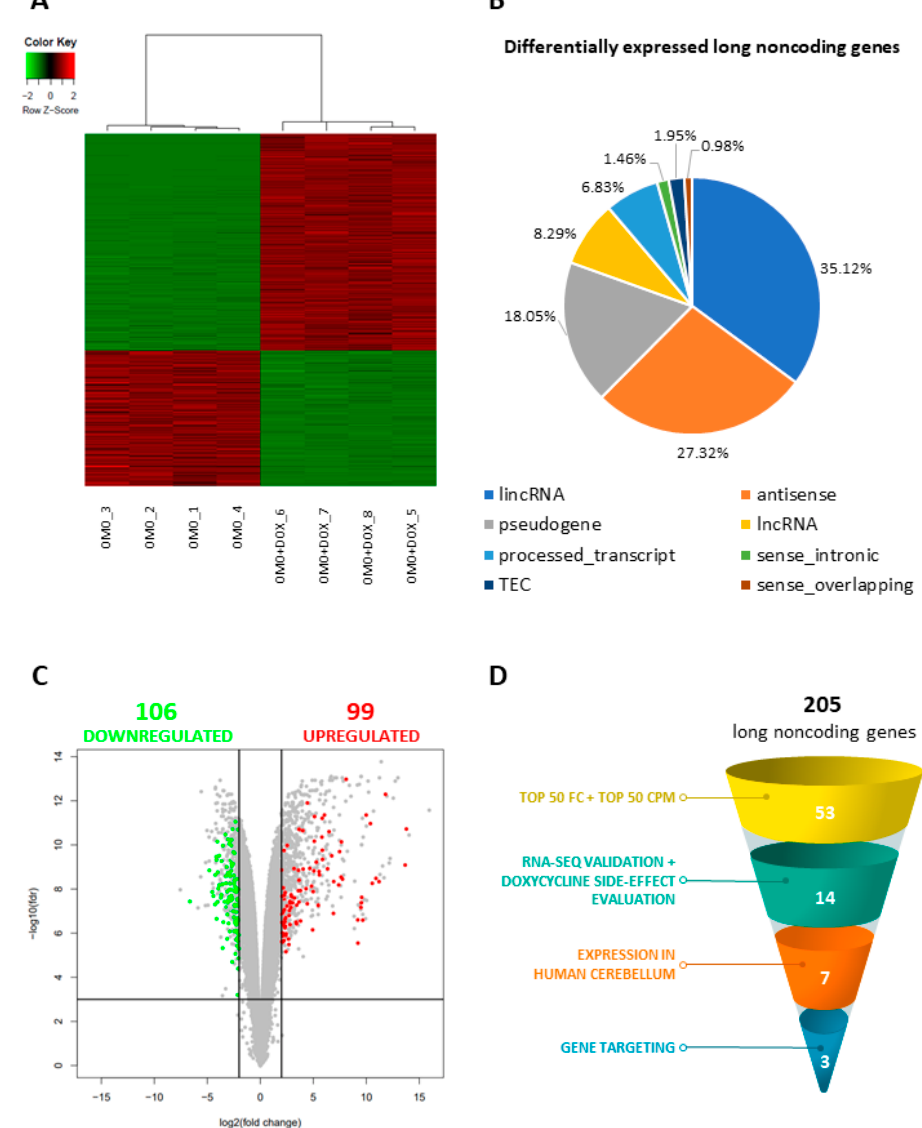
Figure 2. OMOMYC induction affects the transcriptome of D283 MED cells. ( A ) Heatmap shows the relative levels of differentially expressed genes in untreated (OMO) vs. DOX-treated (72 h) D283-OMO cells (OMO + DOX), along with sample (four biological replicates for each condition) hierarchical clustering. Expression levels in the heatmap were calculated by mean-centering the CPM values for each gene. The heatmap represents only the genes displaying CPM > 1 in at least four samples, FDR < 0.01 and log 2 FC > |2|. ( B ) Biotype abundance of the long non-coding genes identified as differentially expressed in untreated vs. DOX-treated D283-OMO cells according to RNA-Seq data analysis (CPM > 1 in at least four samples, FDR < 0.01 and log2FC > |2|). ( C ) Volcano plot showing the distribution of the genes differentially expressed in untreated vs. DOX-treated D283-OMO cells, according to RNA-seq data analysis. Genes were plotted on the basis of statistical significance [ − log 10 (FDR)] and expression variance [log 2 FC]. Non-coding genes (205 hits, CPM > 1 in at least four samples, FDR < 0.01 and log 2 FC > |2|) are highlighted by green (downregulated species) or red (upregulated species) dots, respectively. Protein-coding genes are indicated in grey. ( D ) Schematic representation of the filtering criteria applied to MYC-dependent lncRNAs to select candidates for functional